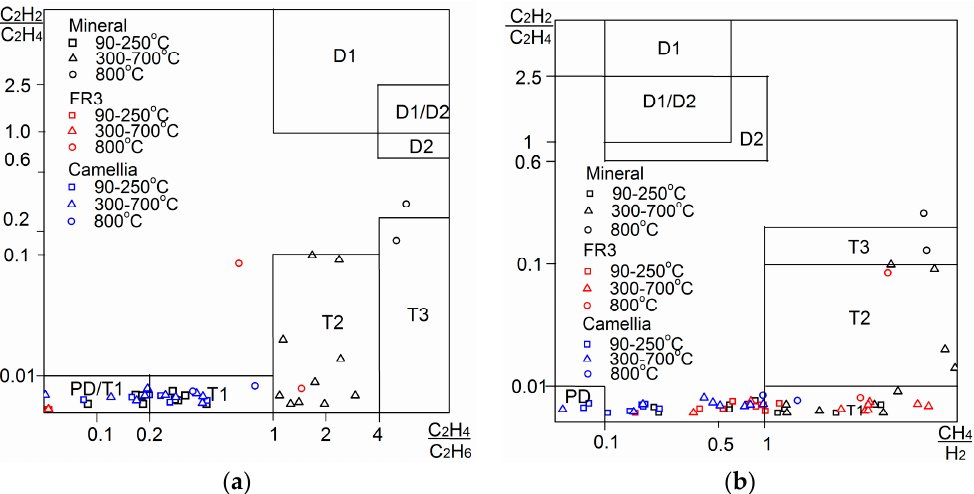
Figure 14. Diagnostic results of simulated thermal faults using graph representation method (data in the figure are expressed as a function of oven temperature): ( a ) According to the ratio of C 2 H 2 /C 2 H 4 and C 2 H 4 /C 2 H 6 ; ( b ) According to the ratio of C 2 H 2 /C 2 H 4 and CH 4 /H 2 .